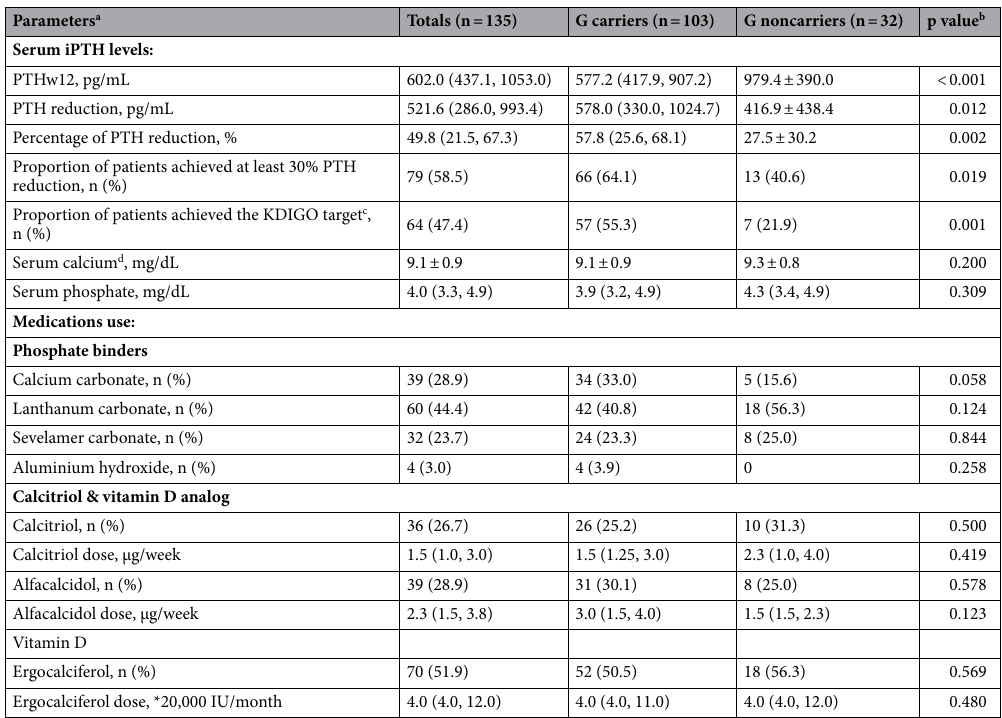
Table 2. Serum parathyroid hormone, serum calcium, serum phosphate and medication use after 12 weeks of cinacalcet treatment. iPTH intact parathyroid hormone, PTHw12 intact parathyroid hormone levels after 12 weeks of cinacalcet treatment. a Continuous data are expressed with either means ± standard deviations if they are normally distributed or medians (interquartile ranges) if they are not normally distributed. b The p values were calculated with the use of the Mann–Whitney U test, or the t-test for comparison between G carriers and noncarriers. c The KDIGO recommended target of two to nine times the upper limit for the PTH assay used for CKD patients on dialysis (130–585 pg/mL). d Serum calcium is reported as albumin corrected values if serum albumin was less than 4.0 g/dL [corrected calcium in mg/dL = measured calcium in mg/ dL + 0.8*(4—serum albumin in